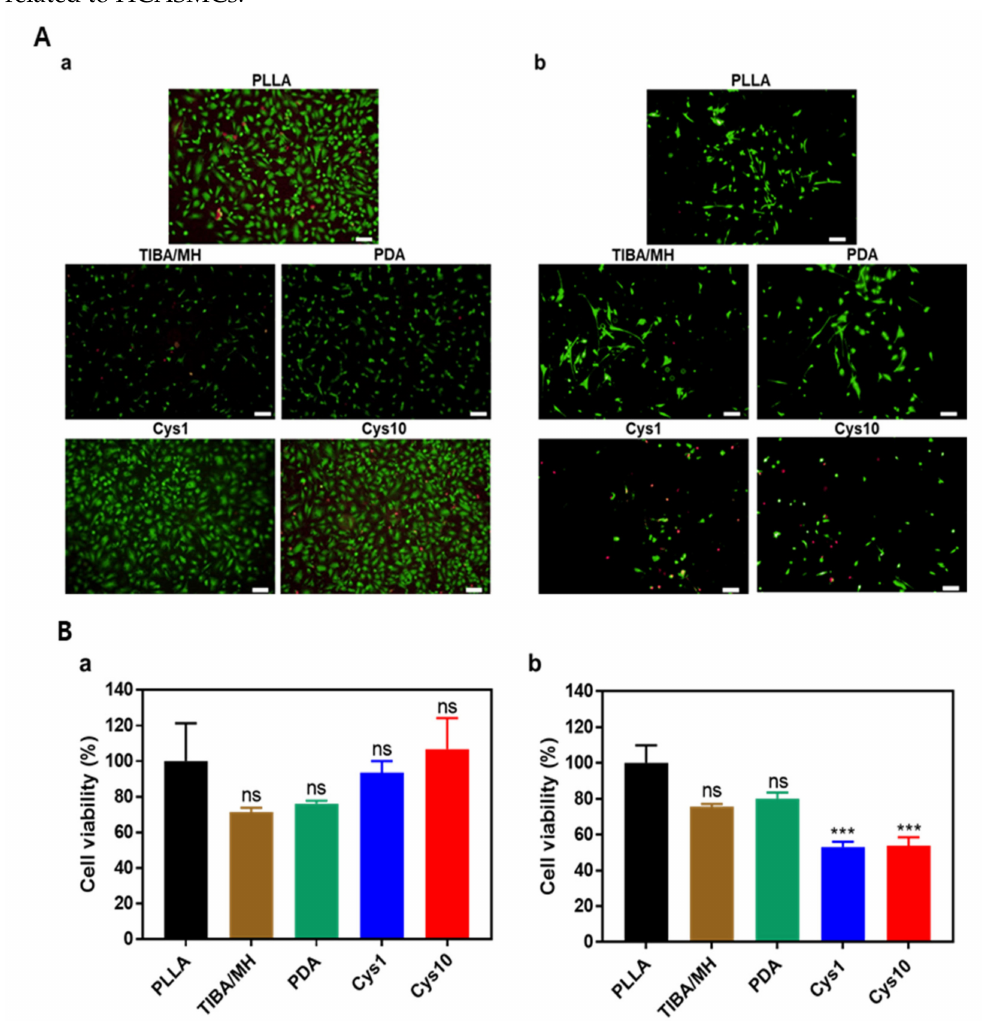
Figure 4. ( A ) Live/dead assay of ( a ) HCAECs and ( b ) HCASMCs with SNAP (Live cells: green and dead cells: red, scale bar = 100 µ m) and ( B ) Cell viability of ( a ) HCAECs and ( b ) HCASMCs on the coated films with SNAP for 24 h (*** p < 0.001 vs.